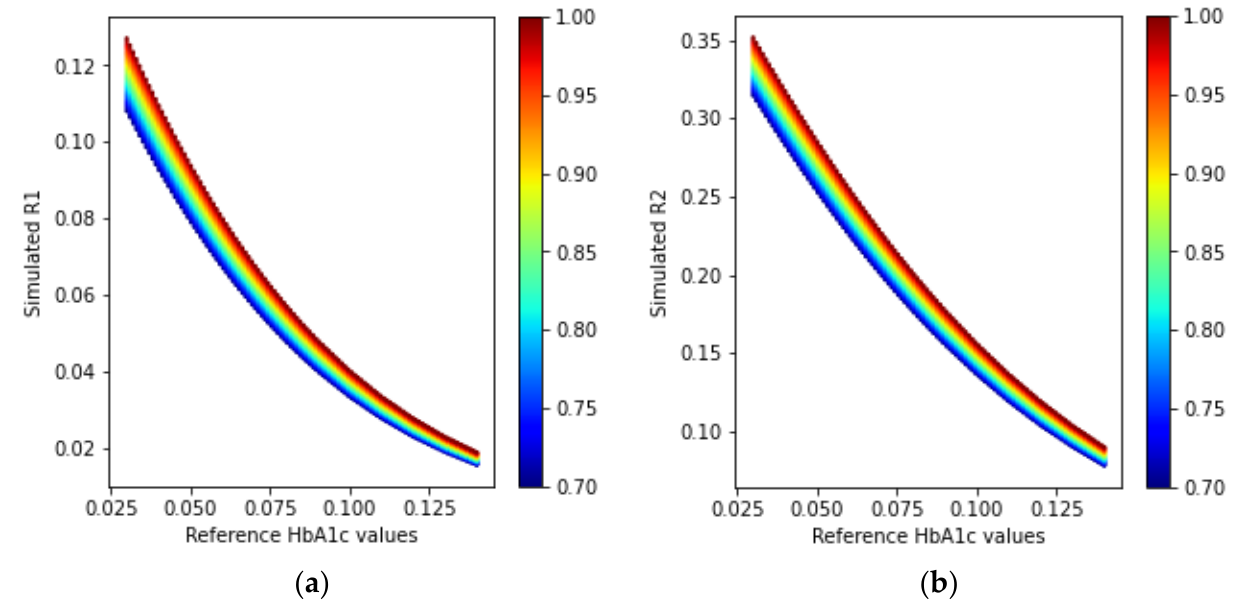
Figure 17. Simulated ratio values ( a ) R1 and ( b ) R2 from the received intensities in the multiple PDs and one wavelength LED arrangement in the wrist model. The color bars at the side of the plots indicate the different SpO 2 values ranging from 70% to 100%.